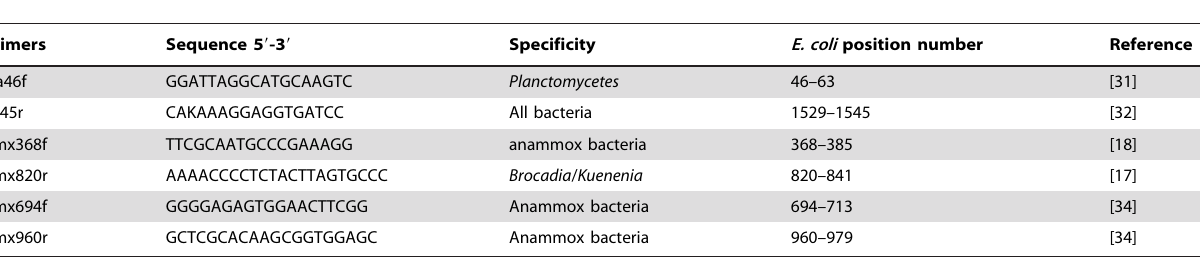
Table 3. Primers used for PCR in this